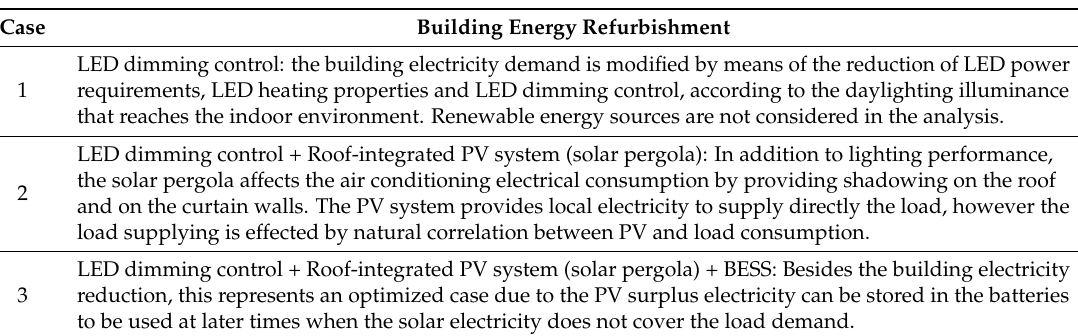
Table 2. Summary description of the cases considered in the